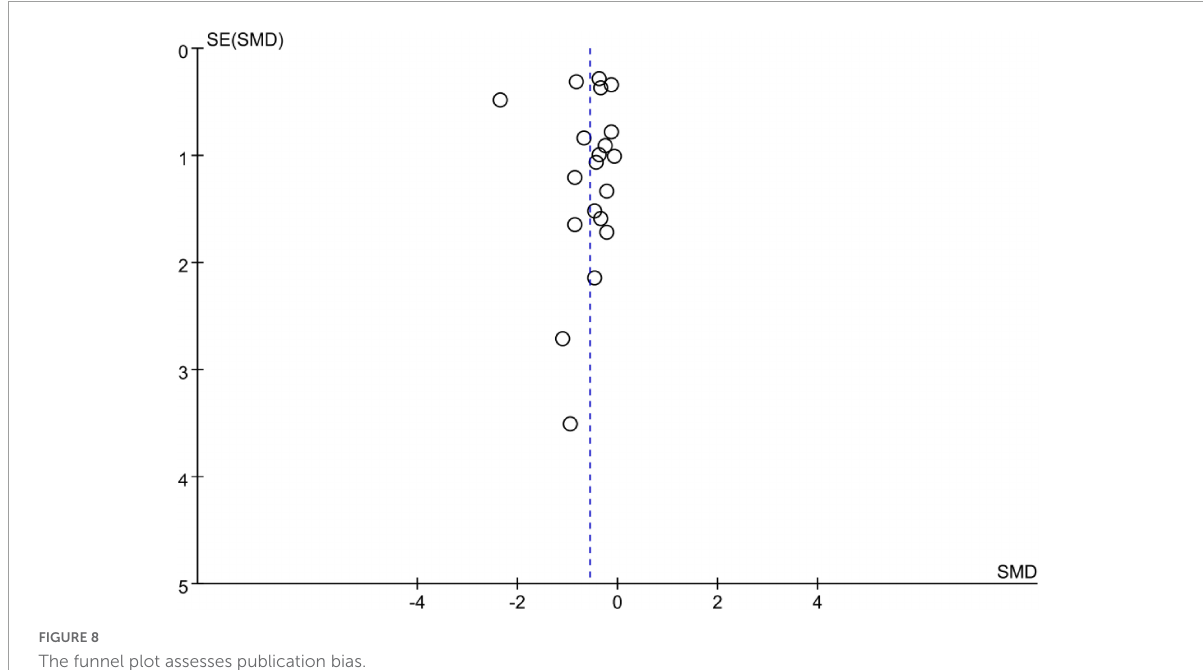
FIGURE8 The funnel plot assesses publication